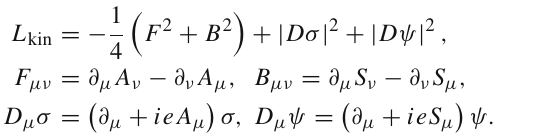
reference [56] as well as [84–101] and references